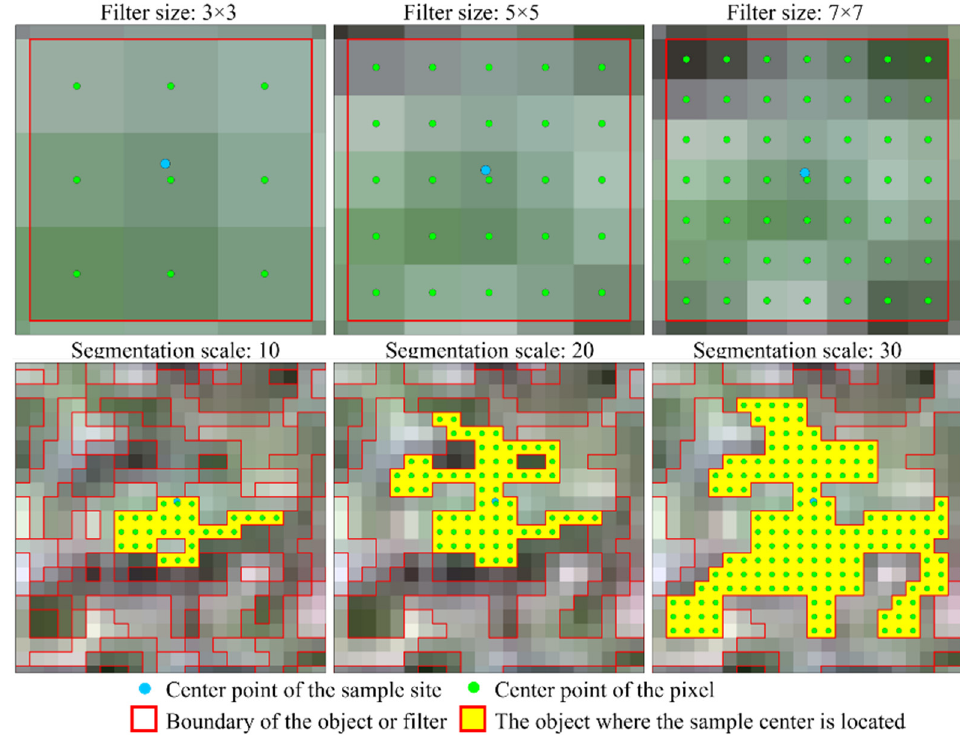
Figure 3. Variable extraction using fi lter-based and object-based methods.